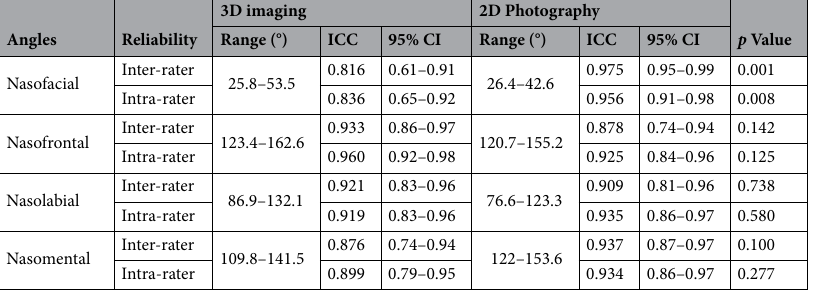
Table 1. Results of nasal angle range and inter-rater and intra-rater reliability of 3D imaging and 2D photography based on intraclass correlation coefficient (ICC) and 95% CI. For all ICC values, p value < 0.001.